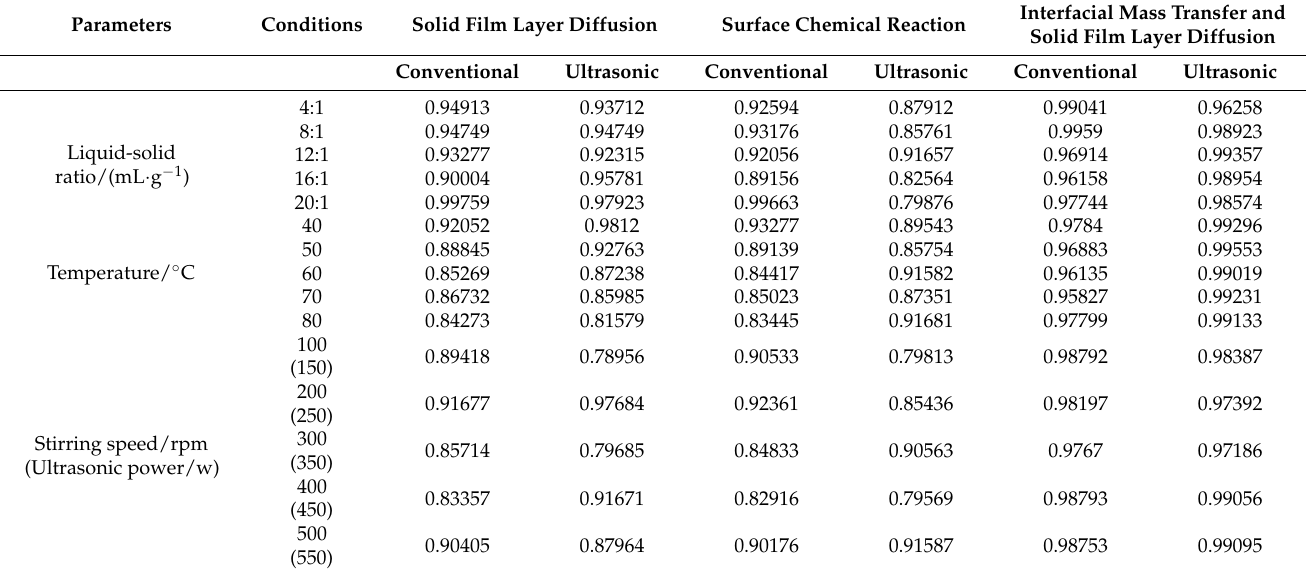
Table 2. Correlation coefficients R 2 for the three kinetic models controlled under different